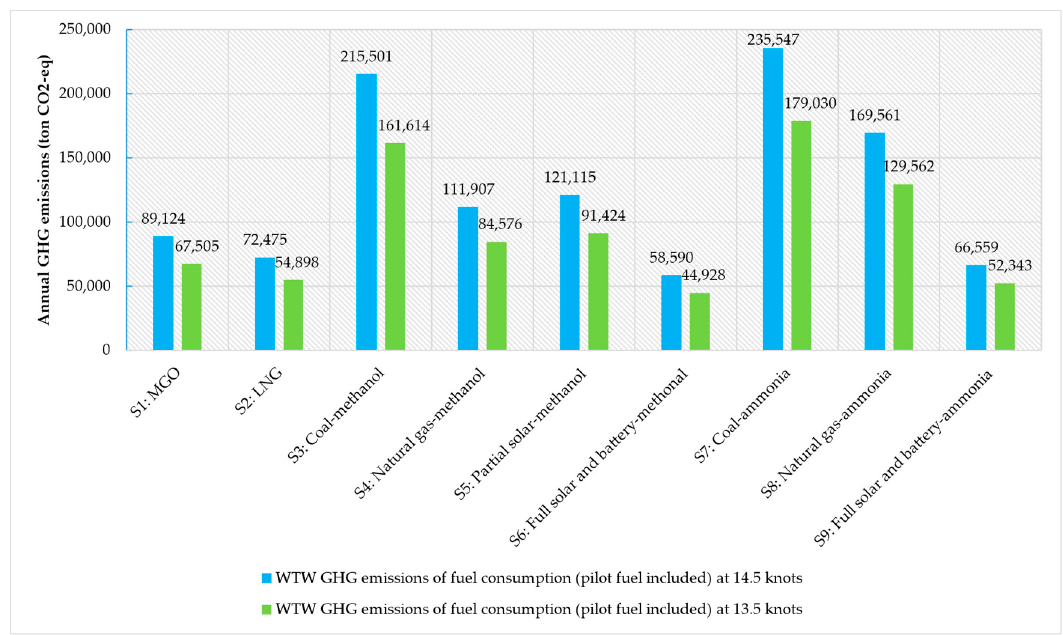
Figure 7. Annual WTW GHG emissions based on annual fuel consumption.